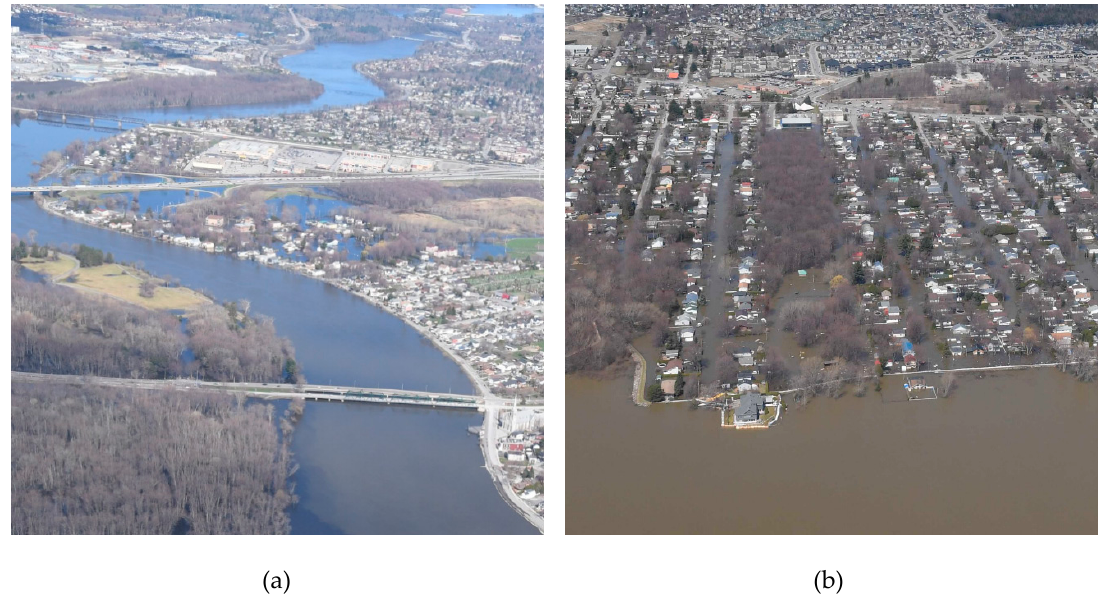
Figure 5. NASP flood images of ( a ) Gatineau, QC on May 4, 2019, and ( b ) Sainte-Marthe-sur-le-Lac on April 29, 2019.